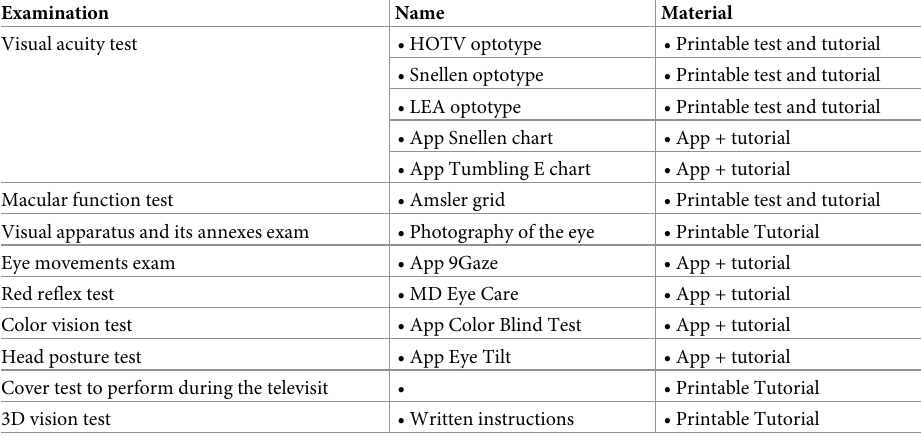
Table 1. TreC Oculistica